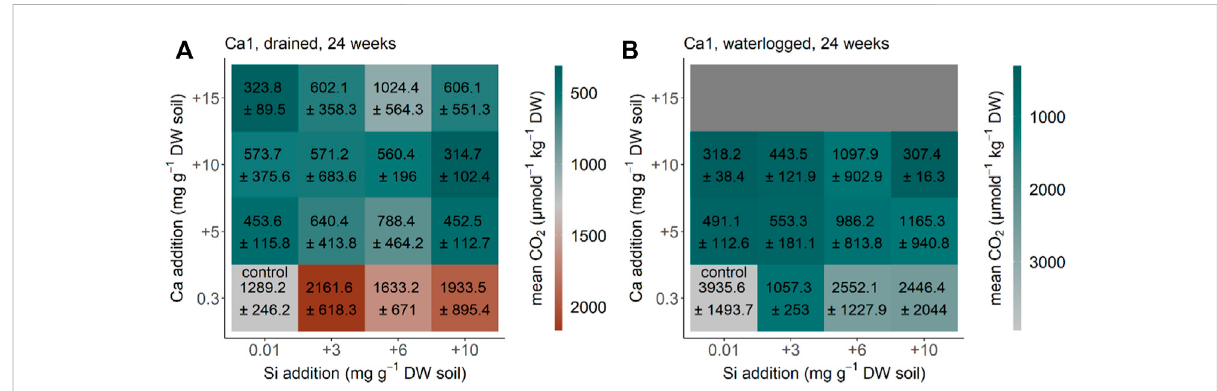
FIGURE 3 CO 2 production for the soil Ca1 from the Canadian Shield, Canada, Baf fi n Bay after 24 weeks (A) drained and (B) waterlogged incubation. Each square represents a treatment (n = 5) with Si (+0, +3, +6, and +10 mg g − 1 DW) and Ca (+0, +5, +10, and +15 mg g − 1 DW).Color represents mean